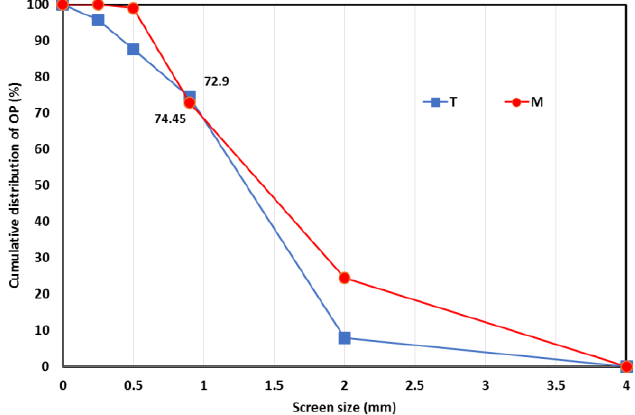
Figure 2. Olive pomace distribution after sieving.